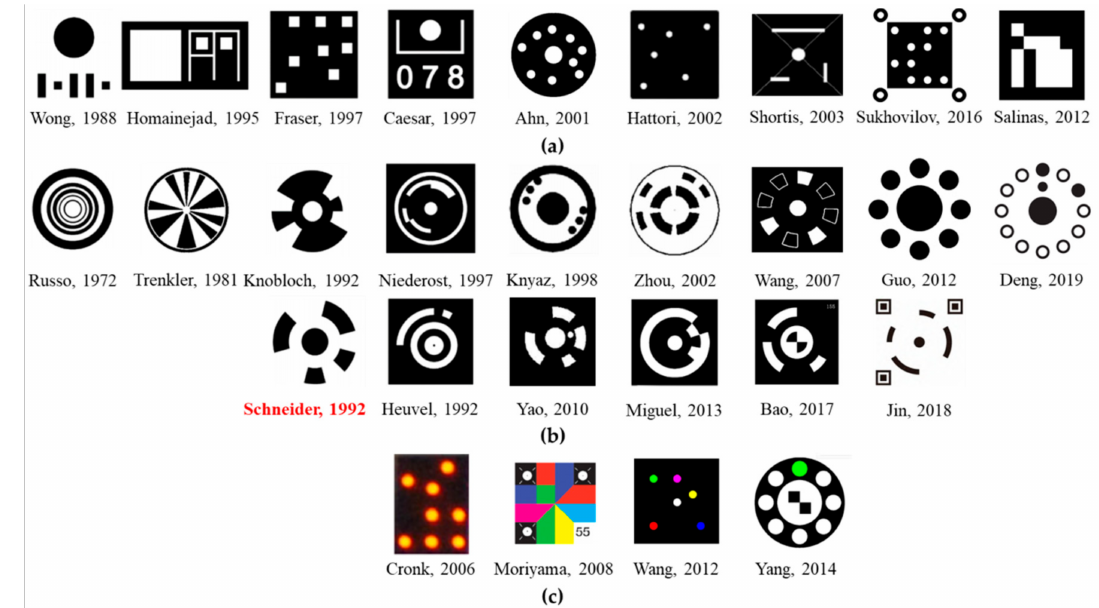
Figure 1. Various types of coded targets: ( a ) dot-dispersing form ( b ) centripetal form ( c ) color-coded